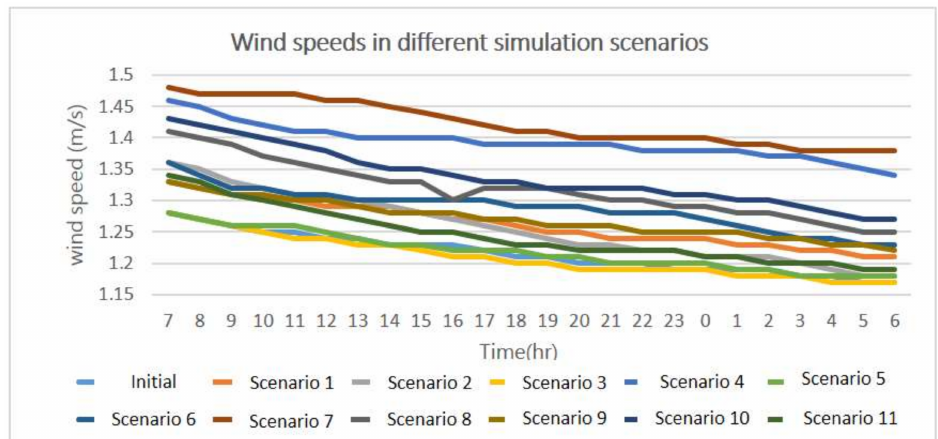
Figure 9. Mean hourly wind speed during a 24-h period in each scenario.